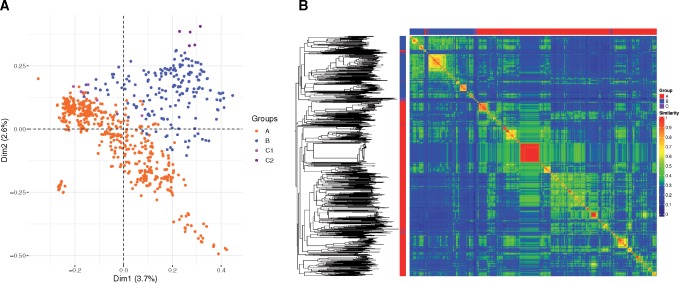
—Accessory genome content of Group A and Group B isolates. (A) Multiple correspondence analysis of AGEs at least 100 bp in length. Orange = Group A, blue = Group B, pink = Group C1, and purple = Group C2. (B) A neighbor joining tree was generated from the Bray–Curtis distances calculated from AGEs at least 100 bp in length and midpoint rooted. The major group memberships of isolates are indicated in the columns along the left and upper axes of the heatmap (red = Group A, blue = Group B, and purple = Group C). The heatmap shows pairwise accessory genome content similarities based on inverse Bray–Curtis distances (1 – d) according to the scale bar.